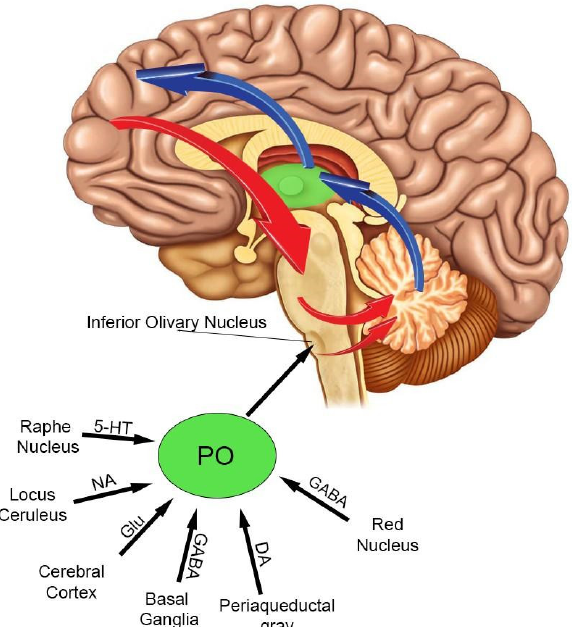
Figure 3. From the inferior olive nucleus originate the climbing fibers that go to the cerebellum, making synapses with the cells of the Purkinje, and to the dentate nucleus. The dentate nucleus, modulated by the activity of this interaction (olivo-Purkinje), projects, through the thalamus, to the prefrontal cortex which in turn projects to the pontine nuclei from which the mossy fibers for the cerebellum depart, thus closing this ring that we could call olivo-cerebello-cortico-pontine loop (oCCP).